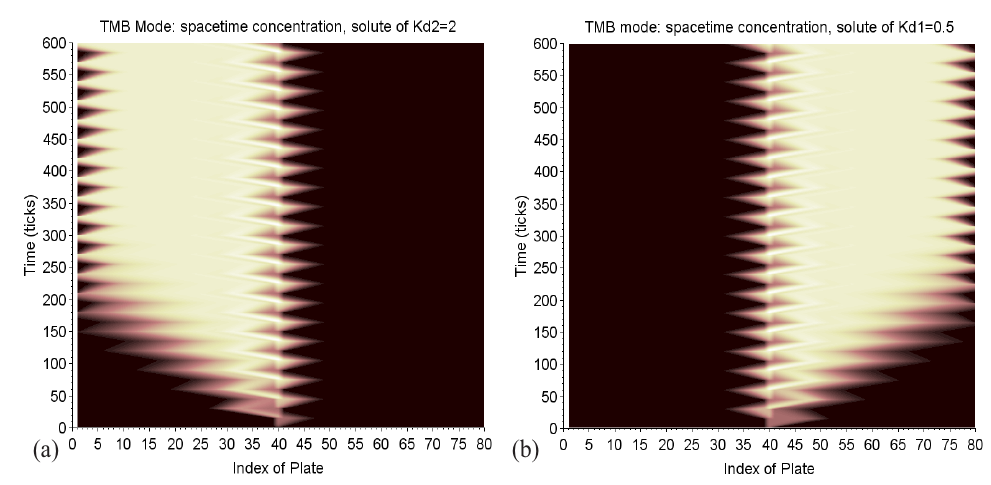
Figure 16. TMB mode: space-time maps of the solute concentration of K d 2 = 2 in solvent 2, on the left ( a ), and of the solute of K d 1 = 0.5 in solvent 1, on the right ( b ). The shades of color highlight the phenomenon of diffusion, like that of ink stains on wet paper. The zigzags in the center represent the alternate diffusion of the continuous injection. The incursion of each solute in the zone, which is unfavorable to it (in dark), is limited. The delivery corresponds to the clear triangles, which point to the plate 1 on the left and 80 on the